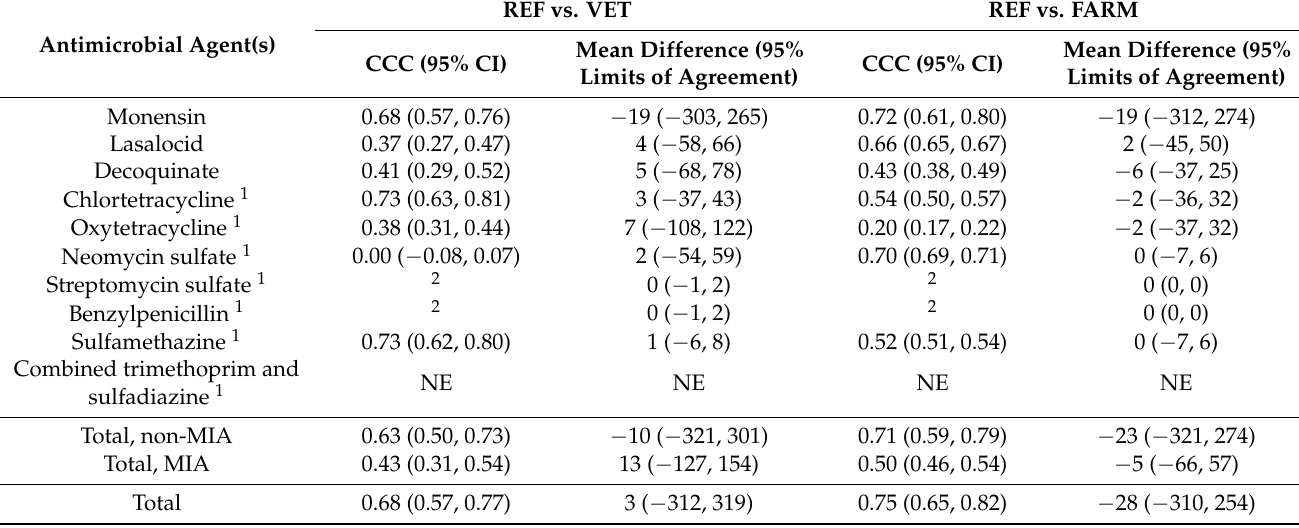
Table A2. Concordance correlation coefficients (CCC) and their 95% confidence interval (95% CI), and mean differences and their 95% limits of agreement, to report agreement for quantification of usage rate of antimicrobials in feed (in DCDbovCA /100 cow-years) between quantification using feed mills invoices (reference method REF) and quantification using veterinary prescriptions (VET method) or in-person interviews of dairy producers (FARM method), by antimicrobial, category (medically important antimicrobials, MIA, or non-MIA), and totally, from a sample of 101 dairy farms from Qu é bec,